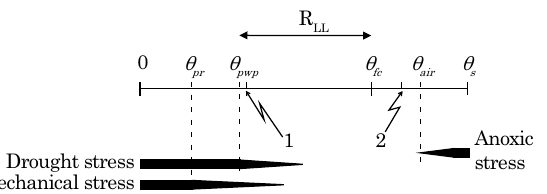
Figure 2. The Least Limiting Water Range ( R LL ) corresponding to case 1 of figure 1, with indication of drought, mechanical and anoxic stresses. The water content indicated with 1 represents a water content within R LL but with near-fatal stress, and water content 2 refers to a water content outside the R LL , but without